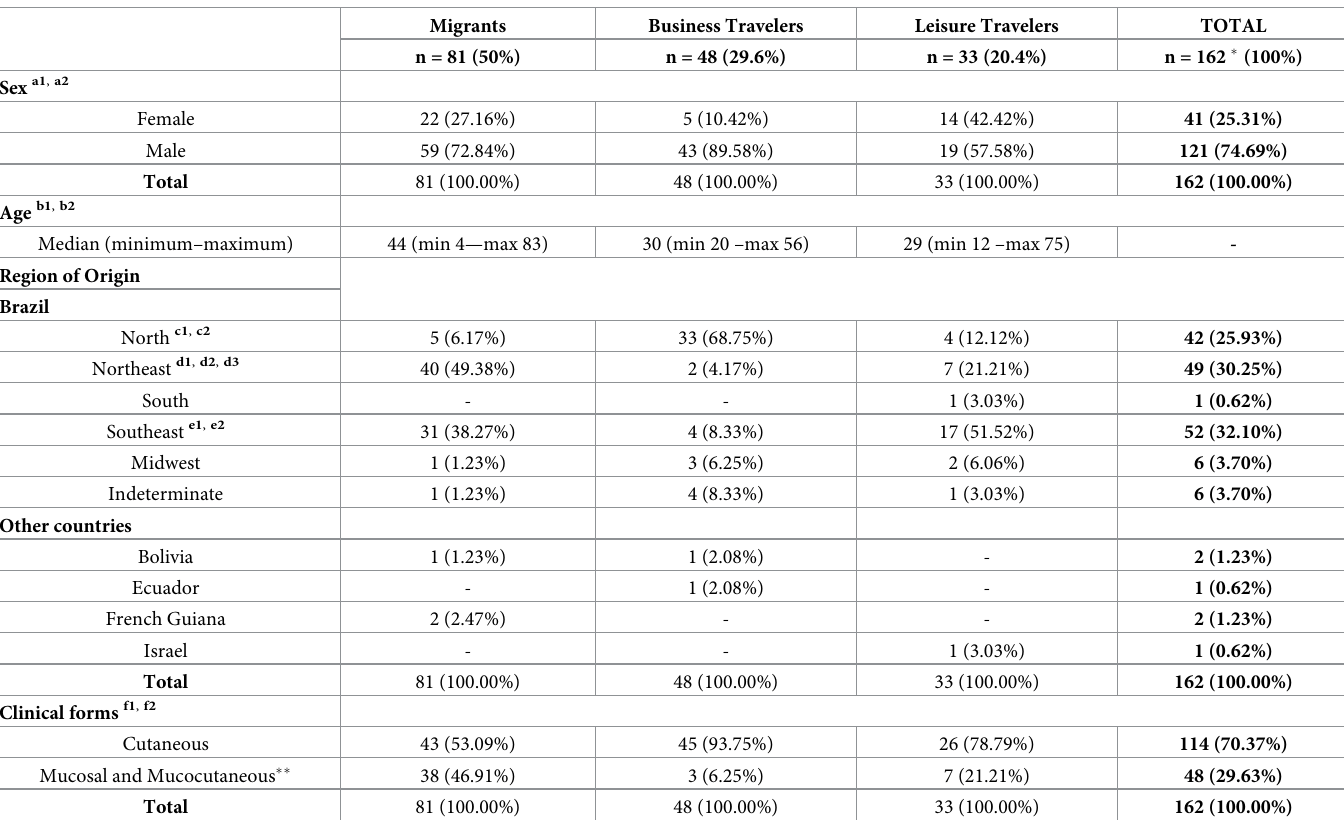
Table 1. Sociodemographic and clinical characteristics of 162 patients � diagnosed with American tegumentary leishmaniasis at NIID-FIOCRUZ from 2000 to 2015. Migrants Business Travelers Leisure Travelers TOTAL n = 81